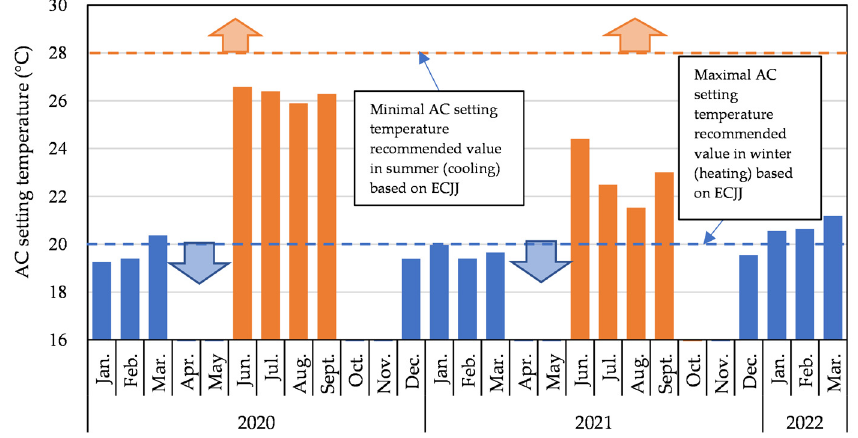
Figure 6. Oji Junior High School’s AC setting temperature (2020–2022).